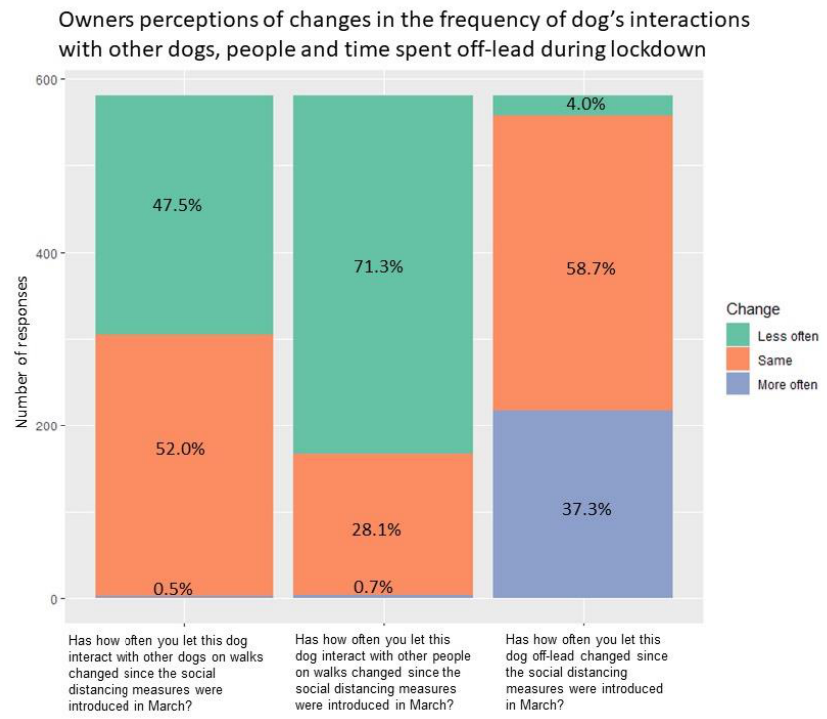
Figure 1. Owner’s perceptions of changes in the frequency of dog’s interactions with other dogs, people and time spent off-lead during lockdown.